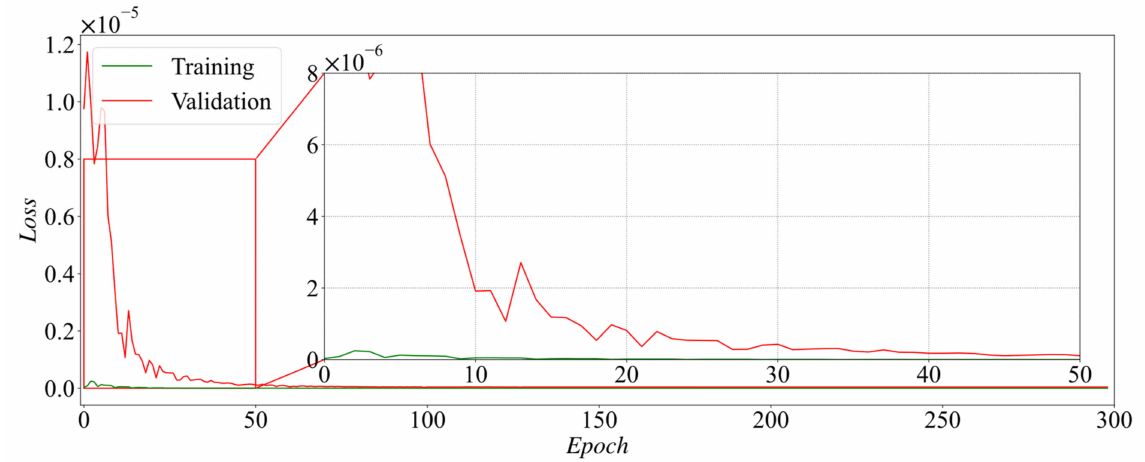
Figure 14. Parameter prediction model loss trends for training and validation sets ( k t